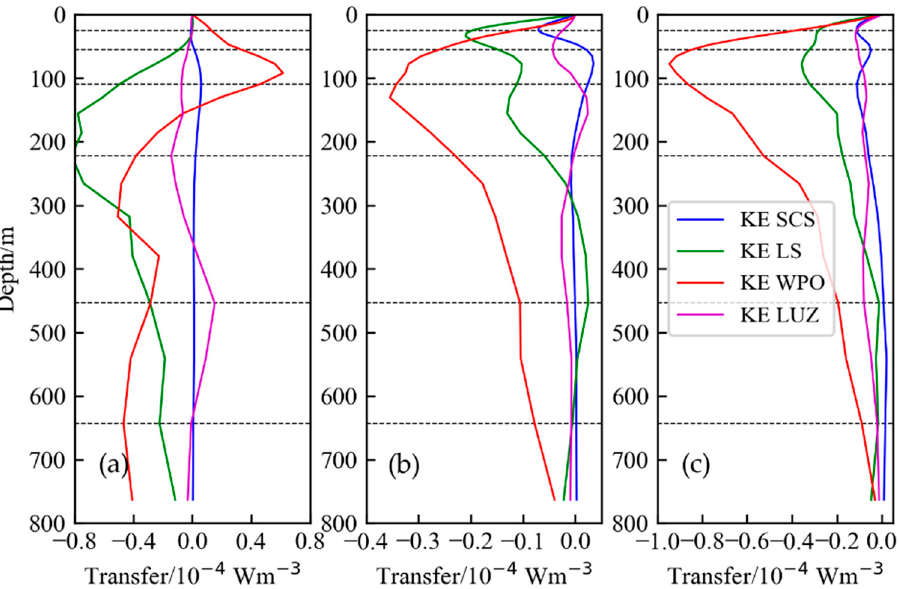
Figure 13. Profiles of temporally and horizontally averaged buoyancy conversion in four subregions (see Figure 1 for locations). The black dotted lines (from top to bottom) in each subgraph indicate depths of 25, 56, 110, 222, 454 and 644 m, respectively. ( a ) b 0 ; ( b ) b 1 ; ( c ) b 2 .